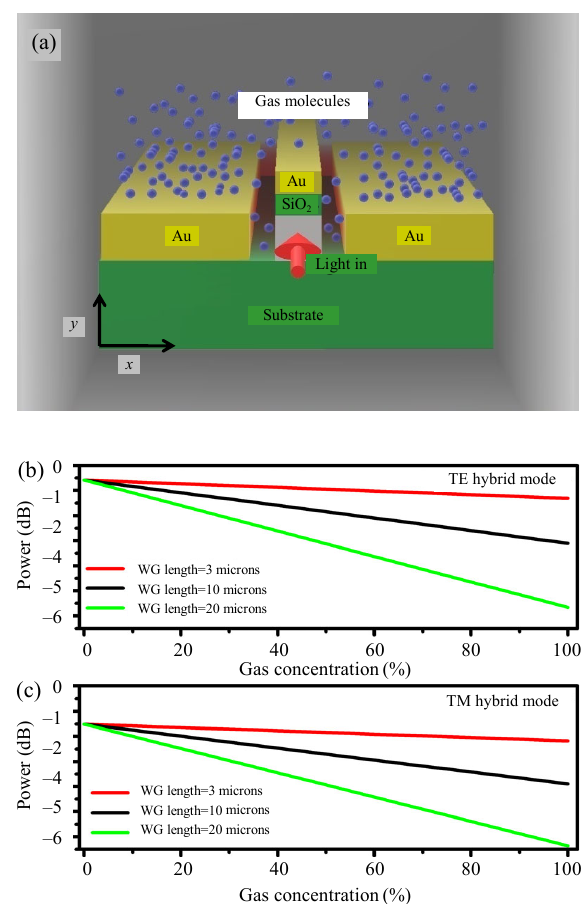
Fig. 8 Schematic representation of (a) gas sensor cell, (b) power variation versus gas concentration for the TE hybrid mode, and (c) power variation versus gas concentration for the TM hybrid